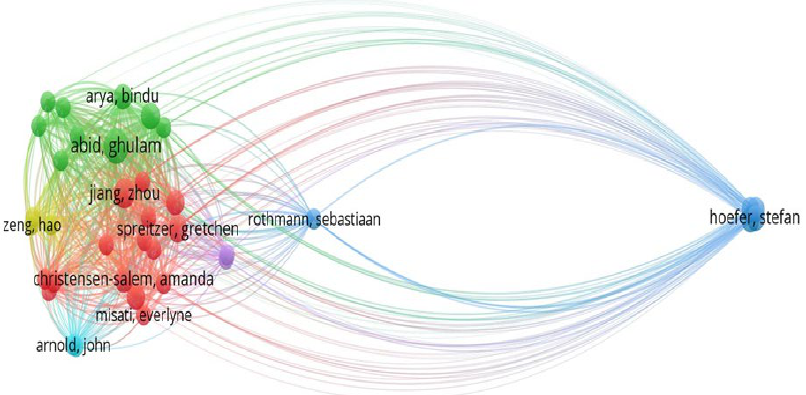
Figure 11. Bibliographic coupling of authors.